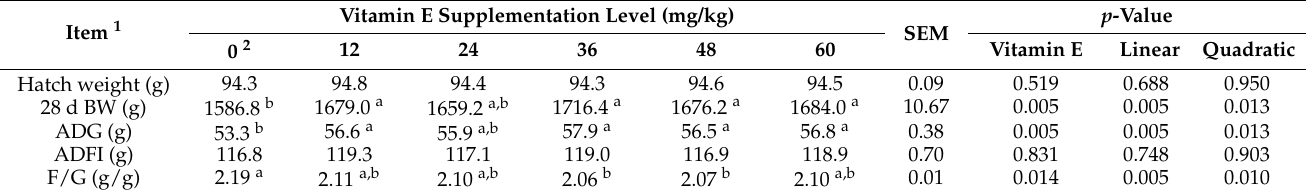
Table 3. Effect of dietary vitamin E supplementation on the growth performance of male Jiangnan white goslings from hatching to 28 d.